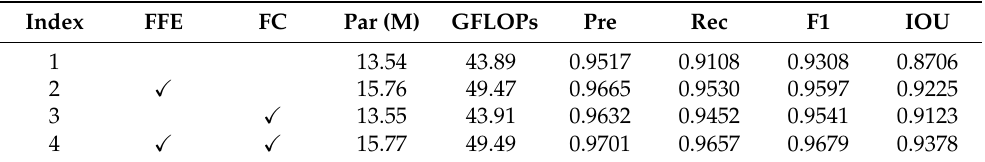
Table 3. Ablation results of full-scale feature extractors (FFE) and full-scale classifiers (FC) on the CDD test set (C = 32). When FFE and FC are not used, we use the plain siamese network (Figure